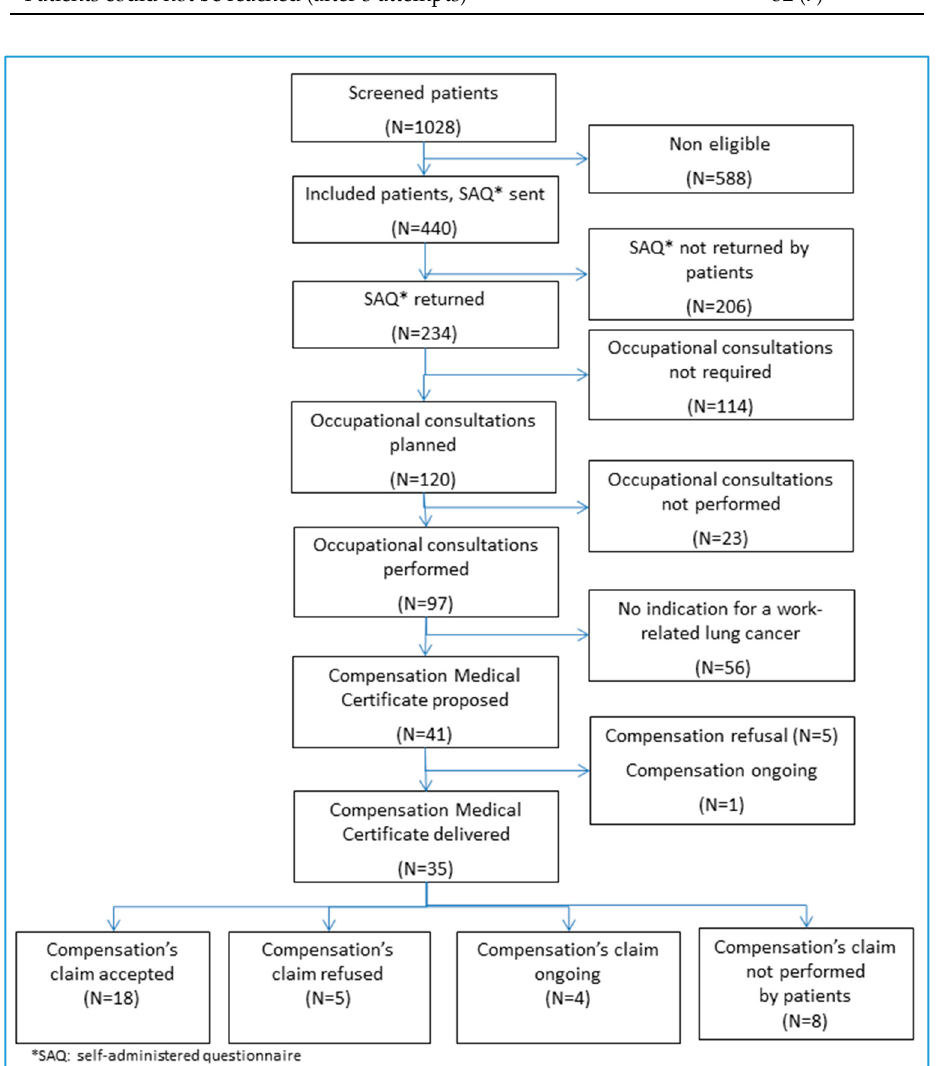
Figure 1. Study flow ‐ chart.